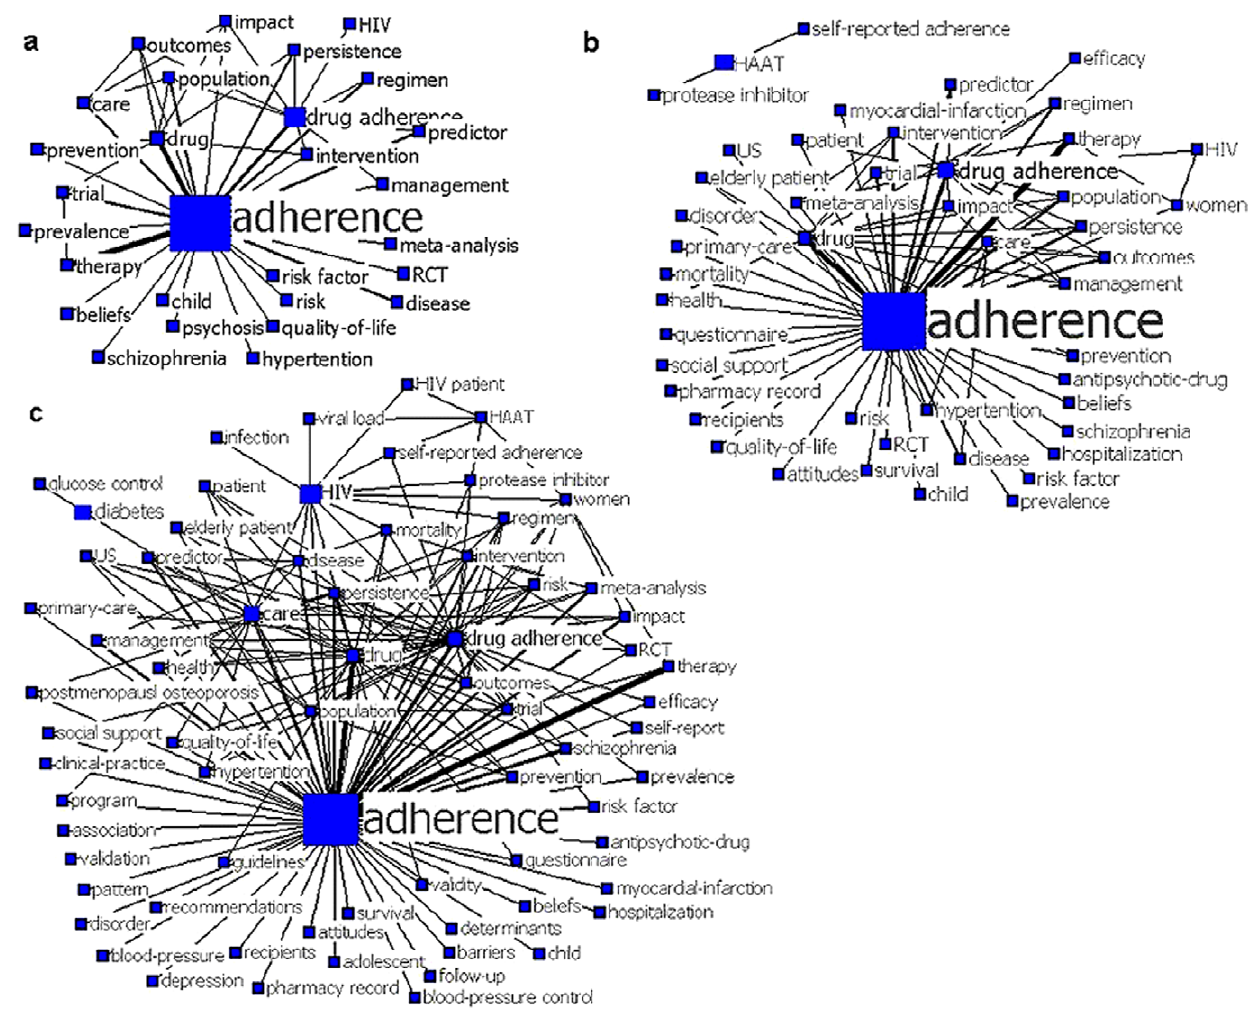
Figure 4. The decomposition maps for keywords in adherence research, 2006–2010. The size of nodes indicates the keywords betweenness centrality, and the thickness of lines indicates the co-occurrence frequency of keywords pairs. The thresholds of co-occurrence frequency in map a ,b and c are $ 20, $ 15 and $ 10, respectively.